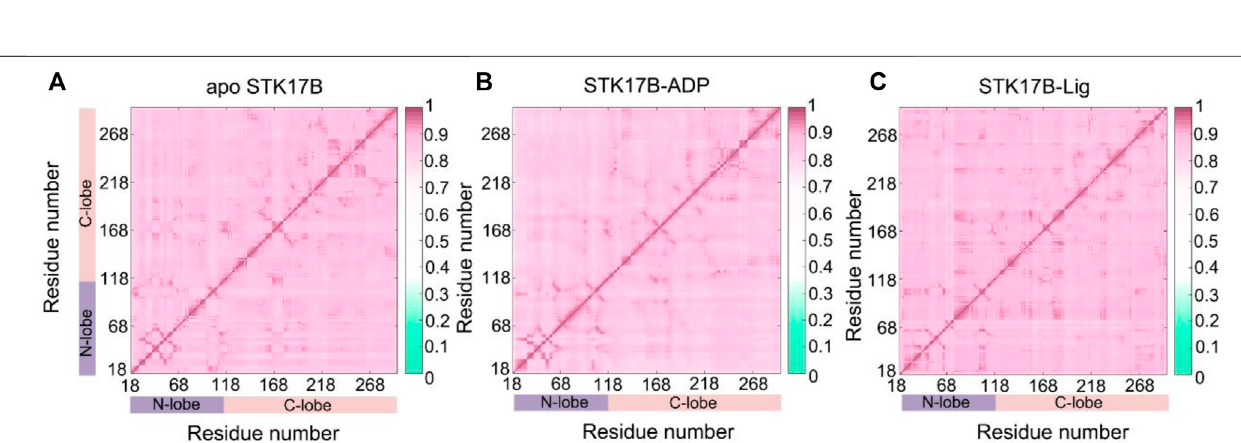
FIGURE3| Thegeneralizedcorrelation(GC ij )matrixofSTK17Bfortheapo (A) ,ADP-bound (B) ,andligand-bound (C) systems.Colorscalesareshownattheright.